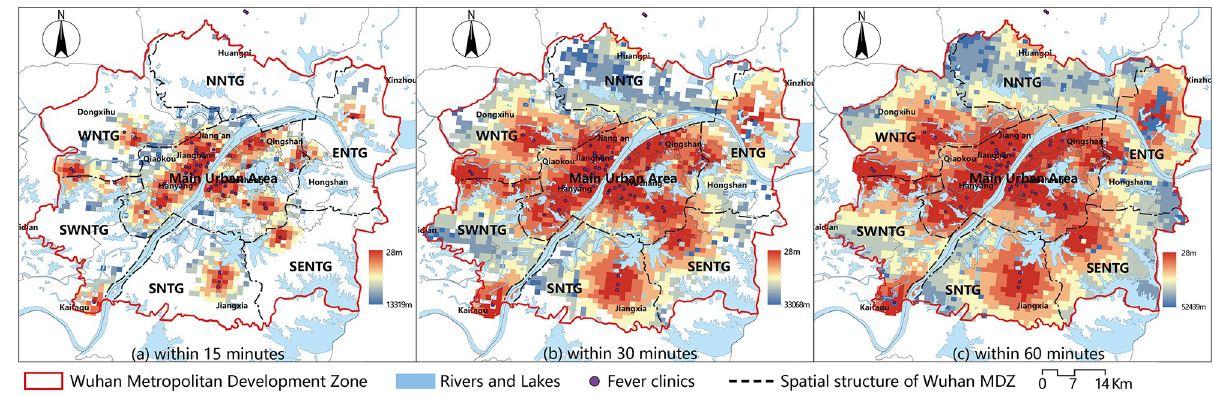
Fig 9. Shortest distance cost of fever clinics. (a)Within 15 minutes, (b) Within 30 minutes, (c) Within 60 minutes.